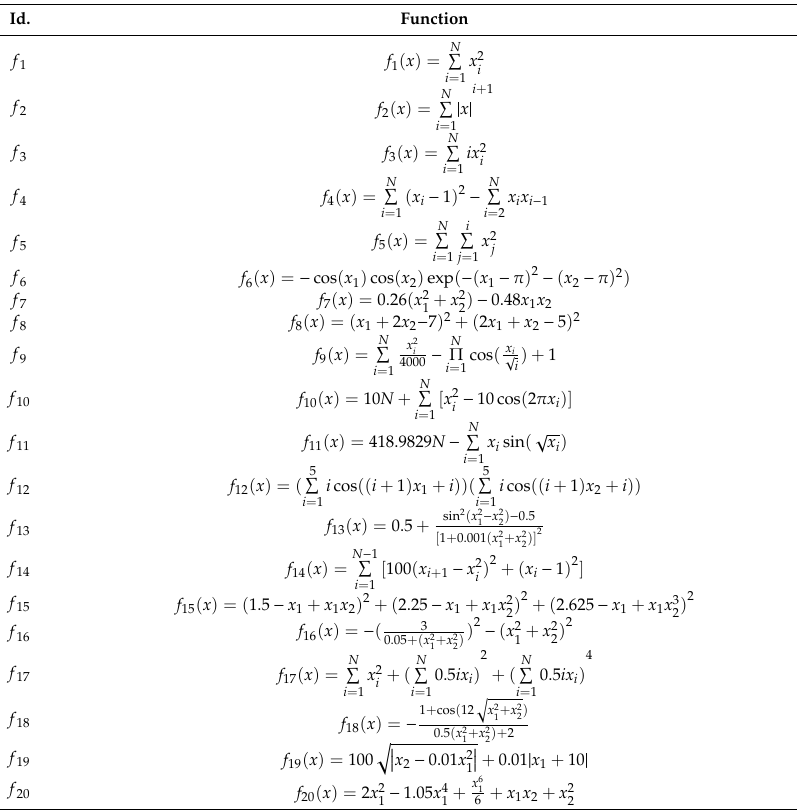
Table 4. Benchmark